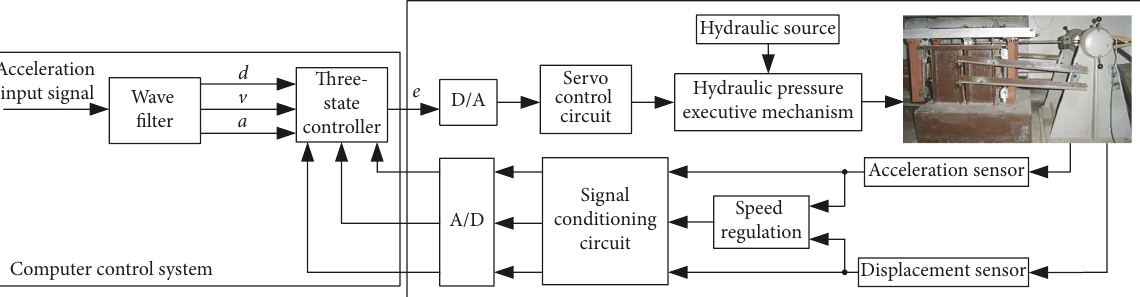
Figure 1: Control system of shaking table.